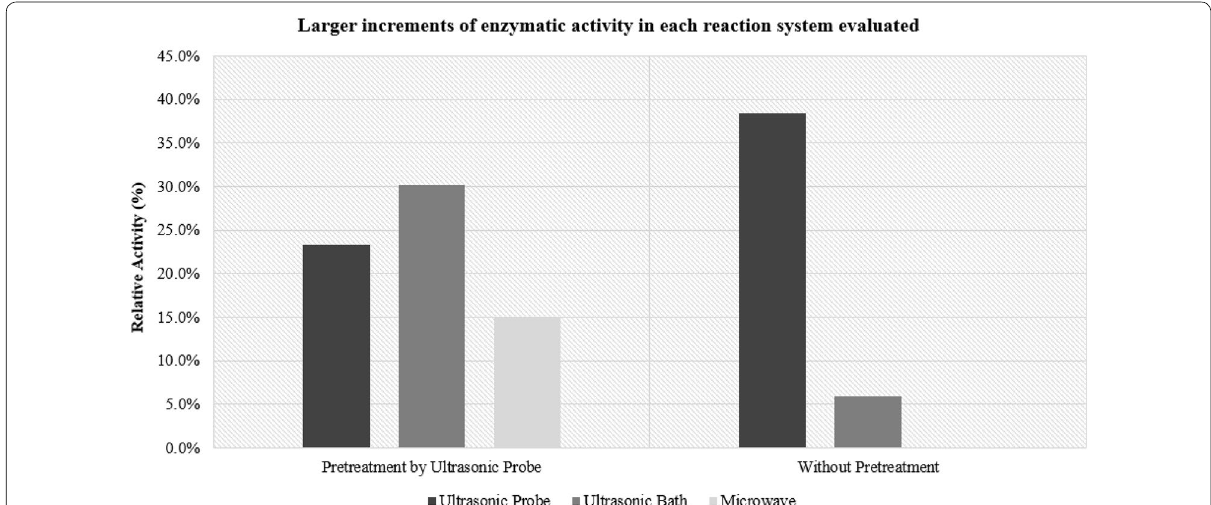
Fig. 1 Larger increments of enzymatic activity of enzymatic extracts obtained from swine hair pretreated using the ultrasonic probe and without pretreatment subjected to the reaction systems ultrasonic probe, ultrasonic bath and